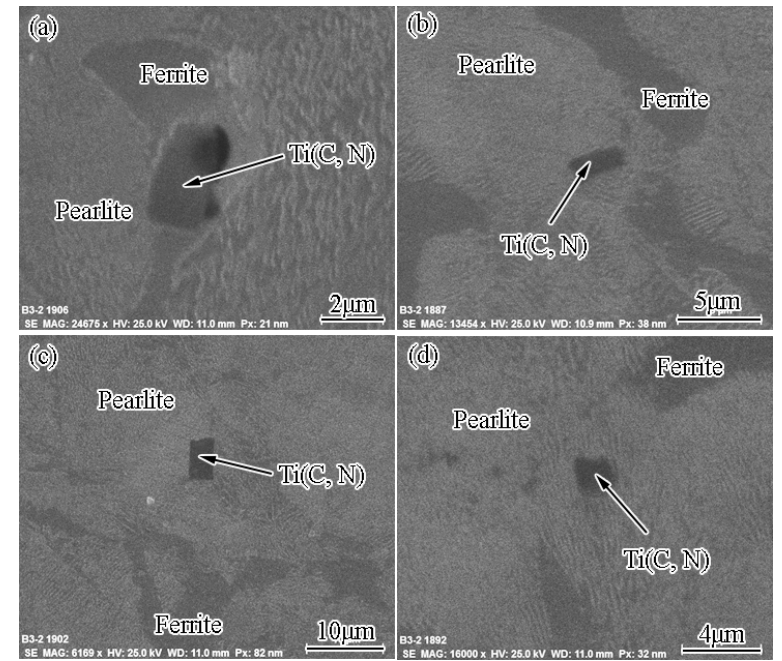
Figure 8. Coarse Ti(C, N) particles located in ferrite ( a ) and pearlite ( b – d ) in steel 1-890. Metals 2018 , 8 , x FOR PEER REVIEW